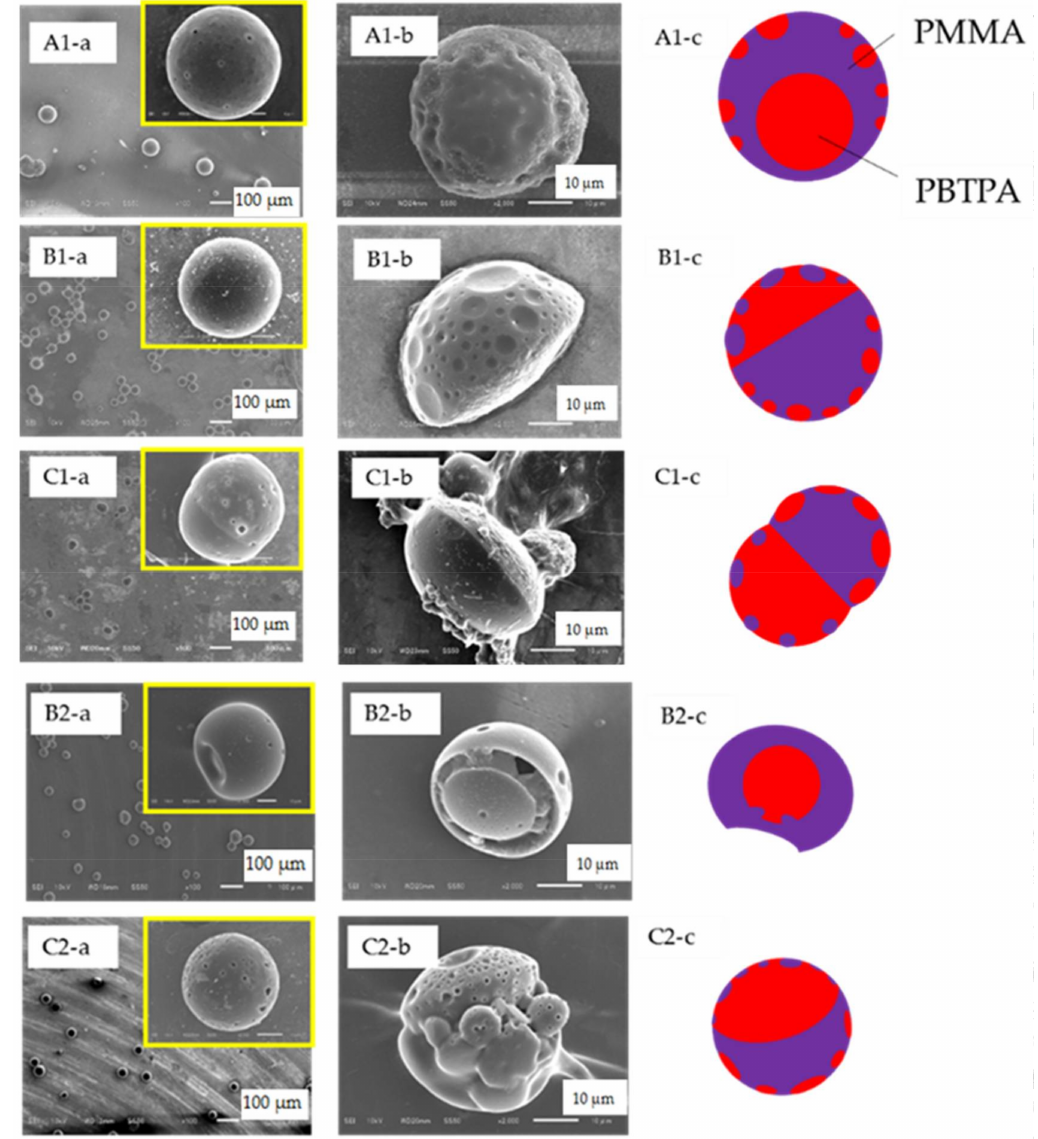
Figure 2. SEM images of microspheres of PBTPA/PMMA prepared with the conditions listed in Table 1 (A1, B1, B2, C1 and C2), ( a ) as-prepared, ( b ) after soaking with acetone, ( c ) schematic